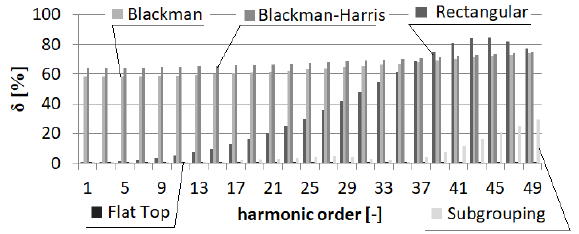
Fig. 3. Distribution of relative error of odd harmonics for the triangular test signal (47 Hz).